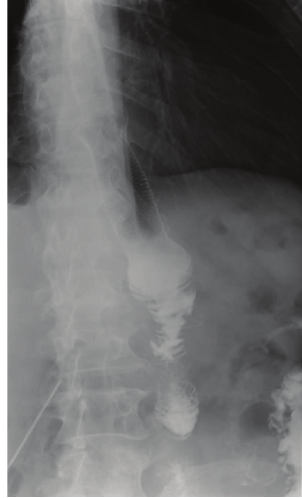
Figure 3: Barium swallow: without extraluminal contrast leakage.